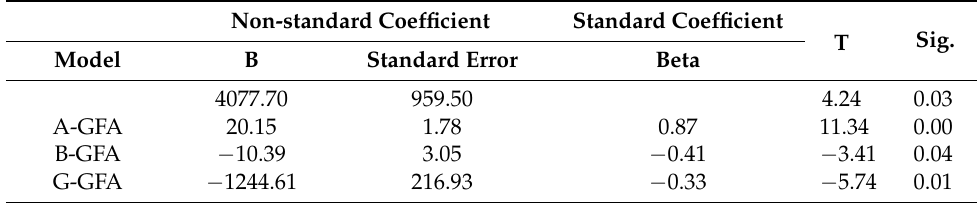
Table 10. Corresponding